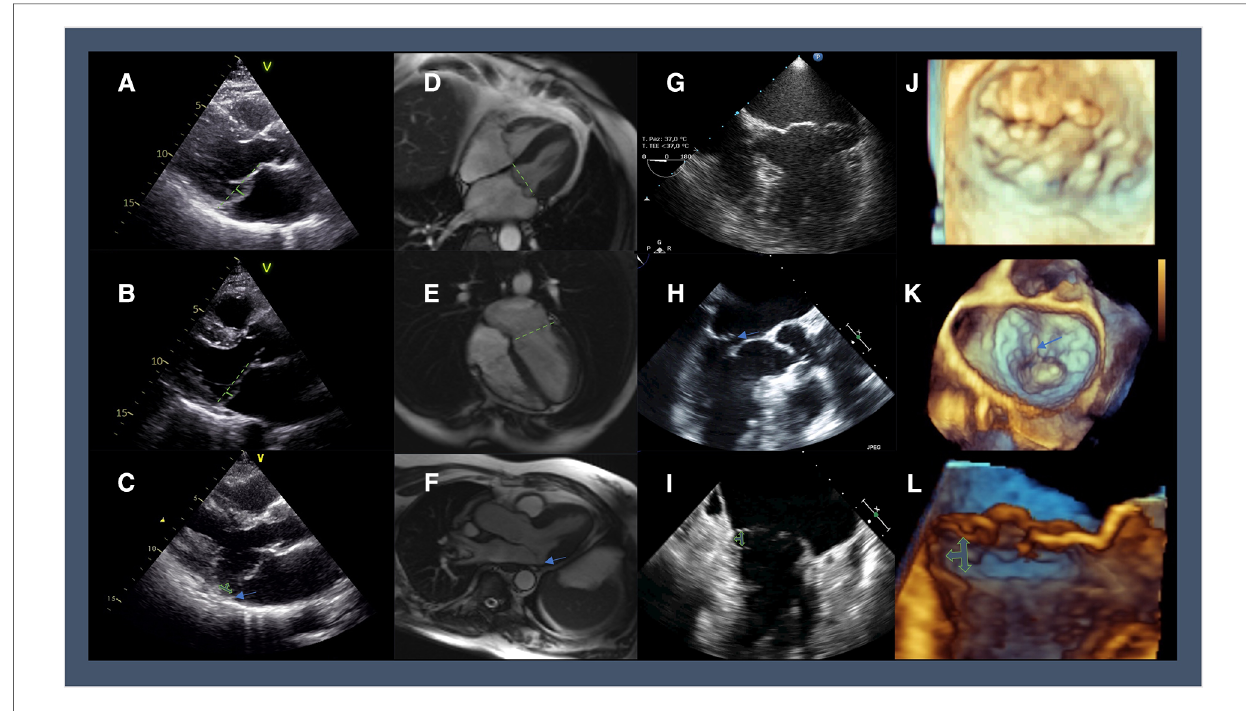
FIGURE 1 Multi-modality imaging highlighting the different features of MVP: 2D-TTE in parasternal long-axis view showing ( A ) diffuse thickening of the mitral tissue and the systolic displacement of posterior lea fl ets 3 mm beyond the plane of the annulus (green line); ( B ) lea fl ets thinning with a prolapse limited to posterior lea fl ets reaching cut-off of 2 mm (green line); ( C ) bilea fl et prolapse and thickening of the mitral valve tissue with posterior MAD (green arrows; a blue arrow shows the detachment of postero-lateral annulus from posterolateral ventricular myocardium); Cine-CMR imaging in end- systolic 4-chamber view showing ( D ) Barlow ’ s disease with bilea fl et thickening of the mitral valve (green line representing the annulus plane); ( E ) fi broelastic de fi ciency with anterior lea fl et thinning and prolapse in the left atrium; ( F ) MAD can be diagnosed in an SSFP three-chamber view in the systole (blue arrow); 2D-TEE ( G ) apical 4-chambers view showing Barlow ’ s disease with a signi fi cantly enlarged mitral annulus and multisegmental prolapse and ( H ) 3-chamber of fi broelastic de fi ciency with P2 fl ail segment (blue arrow); ( I ) 2-chamber view of multiscallop prolapse with MAD (green arrow); 3D zoom aquisition of the mitral valve in surgical view showing Barlow ’ s disease with multisegmental prolapse ( J ), and fi broelastic de fi ciency with P2 fl ail segment and ruptured chords (blue arrow) ( K ); cropped sagittal plane demonstrating a lateral view of the mitral valve with posterior MAD (green arrows) ( L